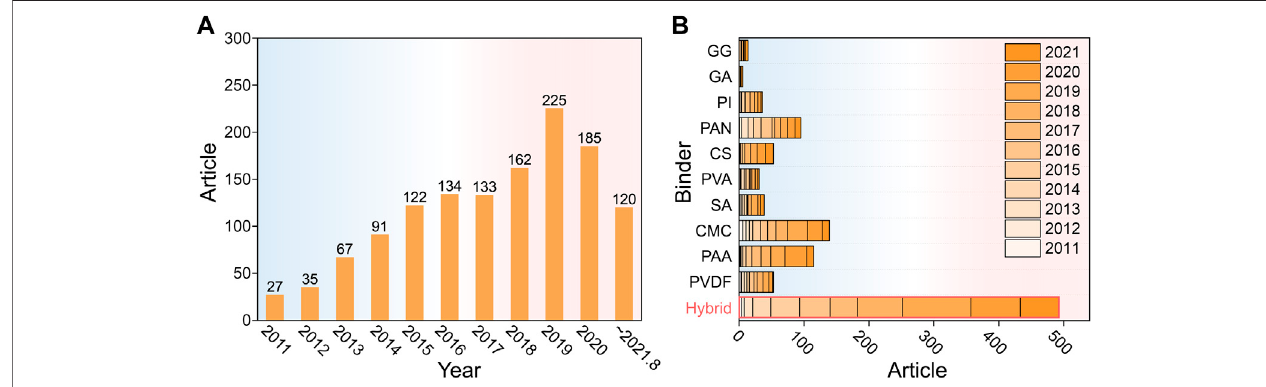
FIGURE 2 | The number of publications on binders for Si-based anodes from year 2011 to August 2021. (A) The overall numbers for binders of Si-based anodes. (B) Subdivided data by 10 typical linear binders and hybrid binders (mentioned in Figure 1 ). Data were collected from Web of Science in August 2021.